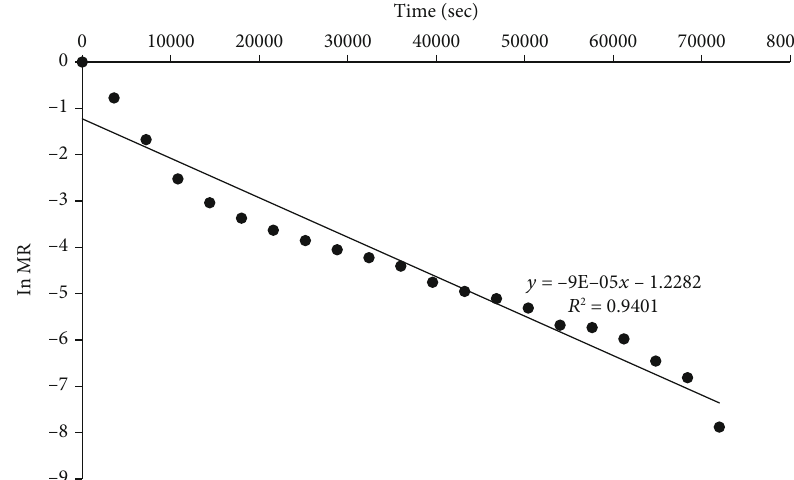
Figure 8: A plot of ln MR and time of jackfruit dried with an oven dryer.